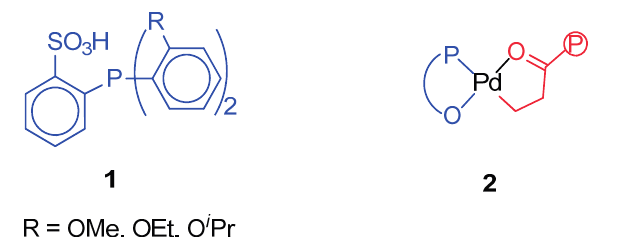
Figure 10. Undeprotonated ligands for the nonalternating CO-ethene copolymerization ( 1 ); β -chelate with the P-O − ligand ( 2